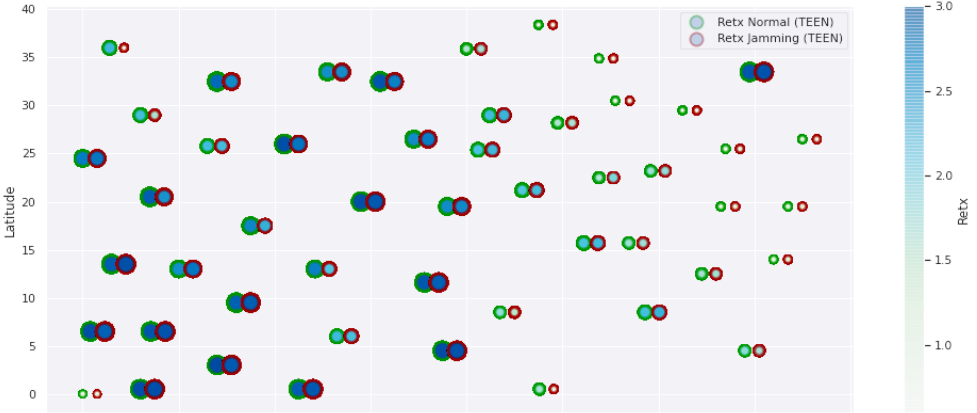
Figure 2. TEEN retransmissions under normal conditions and